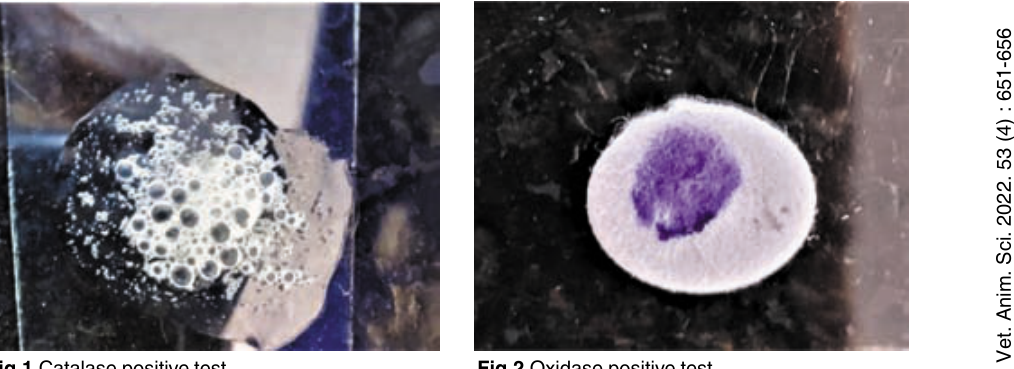
Fig.1 Catalase positive test Fig.2 Oxidase positive